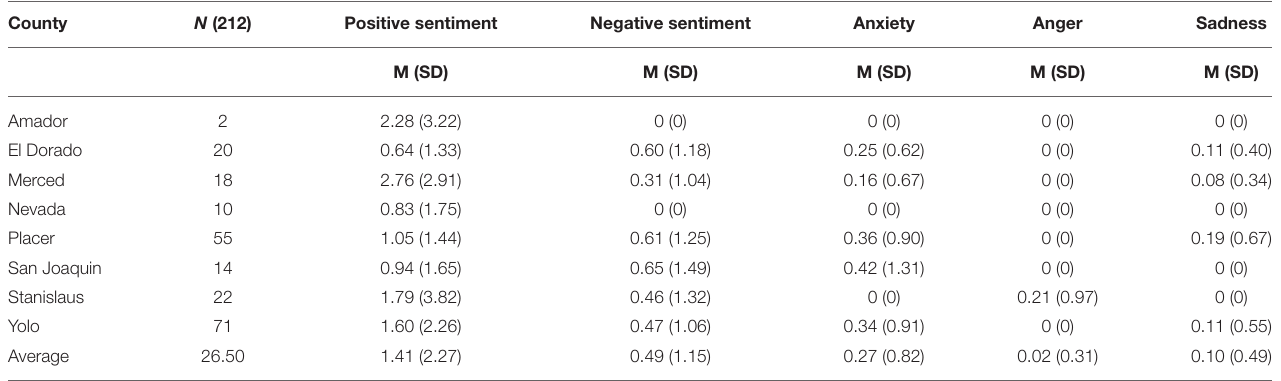
TABLE 2 | Average sentiments and negative emotions of public Facebook posts about the HPV vaccine. County Positive sentiment Anxiety